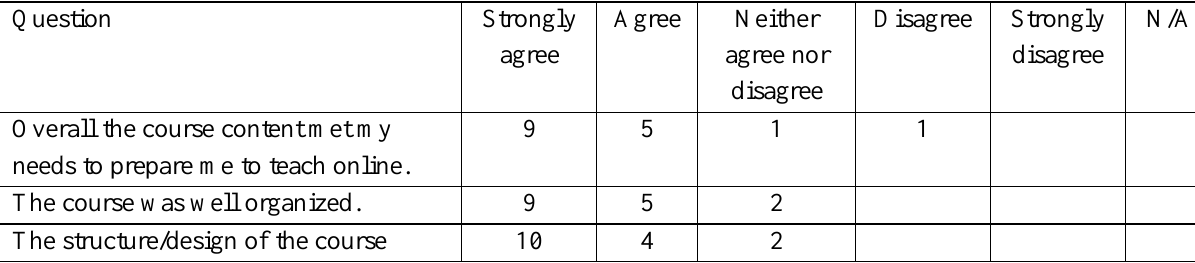
Strongly Agree Neither agree Disagree Strongly agree nor disagree